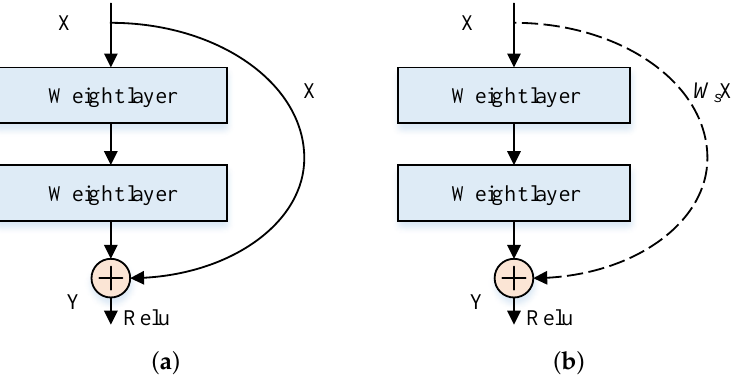
Figure 5. Two modes of shortcut connection. ( a ) Input and output channels are same. ( b ) Input and output channels are